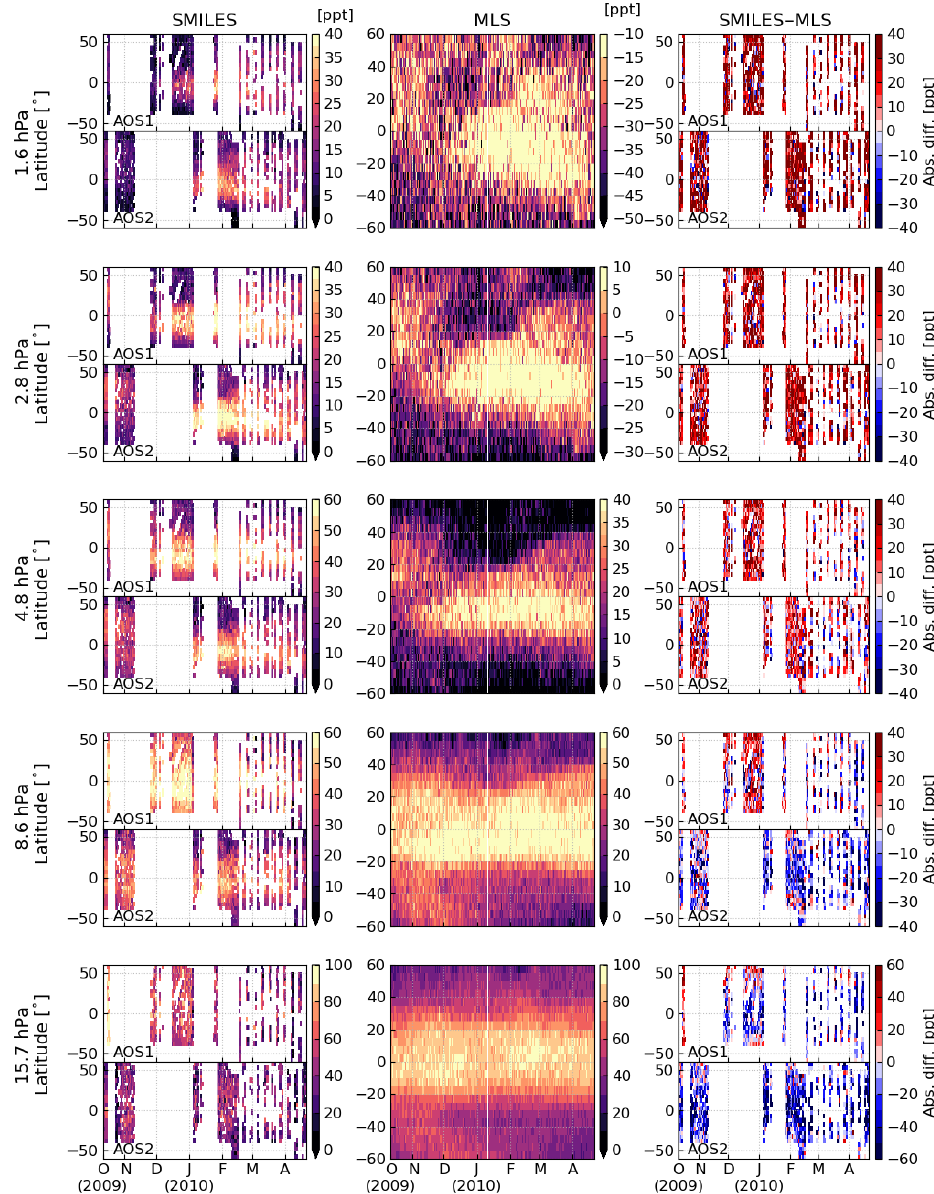
Figure 10. Seasonal variation in SMILES and MLS CH 3 CN observations and the absolute difference for each pressure level, as a function of latitude. Observation date and latitude bins are 1d and 5 ◦